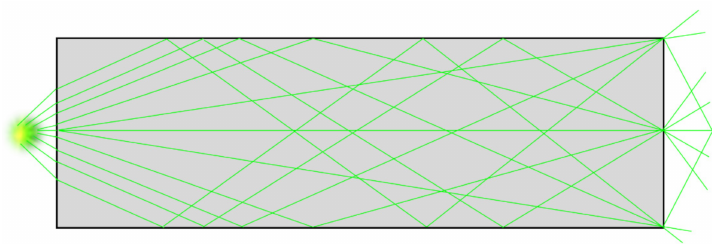
Figure 2. Light propagating in the homogenizing pipe.